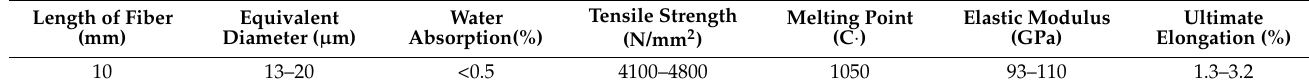
Table 2. Mechanical characteristics of basalt fiber (BF).